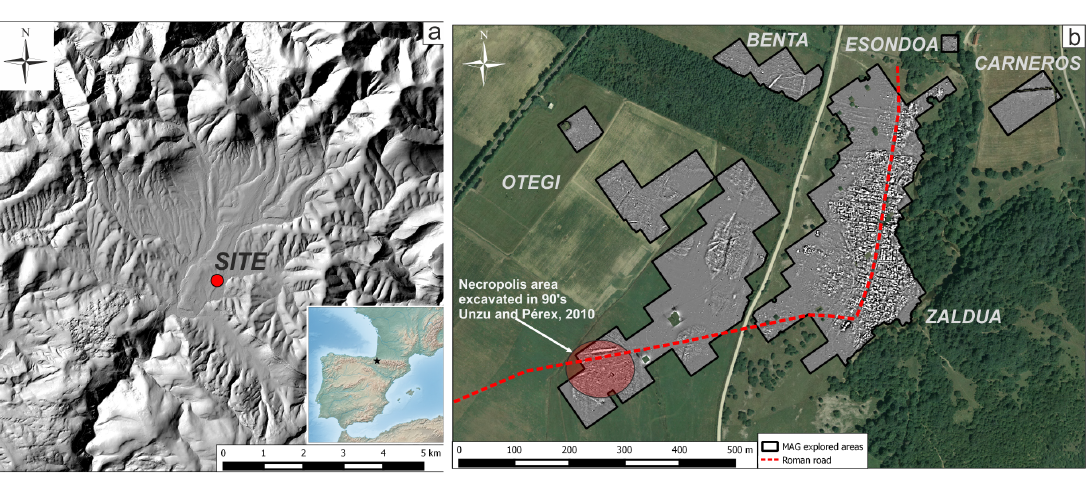
Figure 1. ( a ) Geographical location of the studied archaeological site on an elevation map created from the LiDAR data provided by the c (cid:13) Instituto Geográfico Nacional de España (5 m cell). ( b ) Magnetic response map in the overall explored area ( − 8 nT black, +8 nT white). The Roman road and the necropolis area excavated are indicated. Modified from [26] and reproduced by permission of ARANZADI Society of